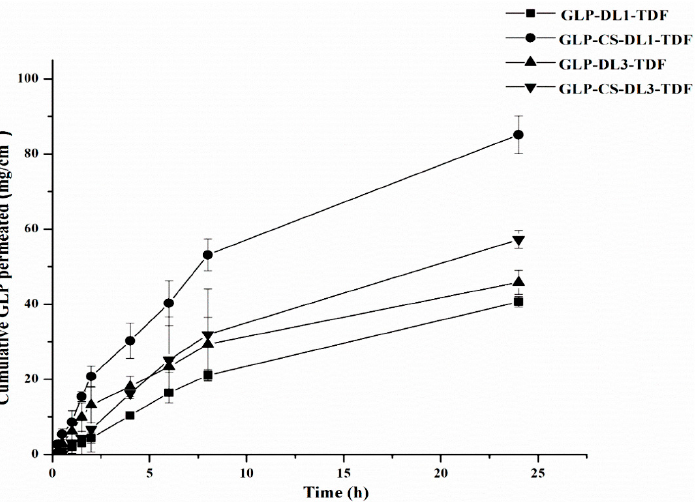
Figure 4. Ex vivo skin permeation profiles of GLP-DL1-TDF, GLP-CS-DL1-TDF, GLP-DL3-TDF, and GLP-CS-DL3-TDF (mean ± SD, n = 3). Table 5. Cumulative drug permeated and permeation parameters of GLP from different transdermal films ( n = 3, mean ±